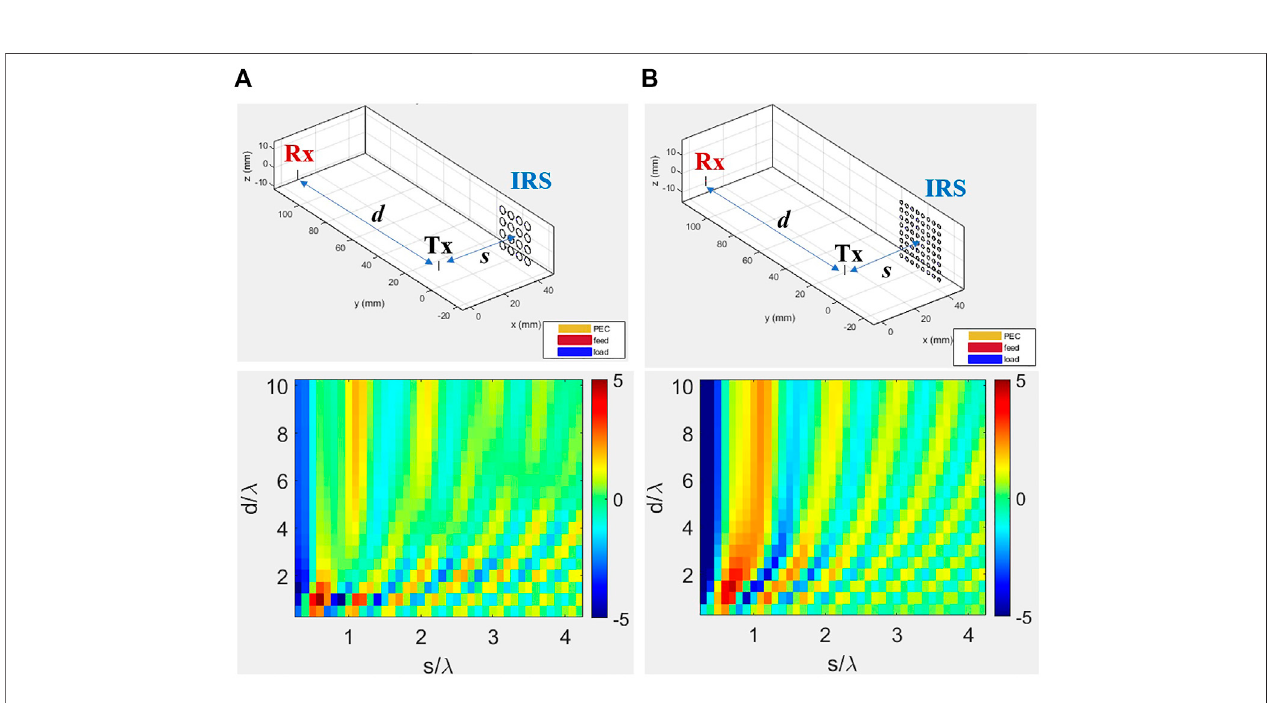
FIGURE8| Variation of Δ P (in dB)withrespect to d / λ and s / λ for twoIRS-assisted SISO Comm-linksoperating at 28 GHz: (A) N (cid:1) 4, r (cid:1) 0.2 λ , (B) N (cid:1) 8, r (cid:1) 0.1 λ .For both, we keep keeping p (cid:1) 2 r +2 mm (see Figure 1 ).